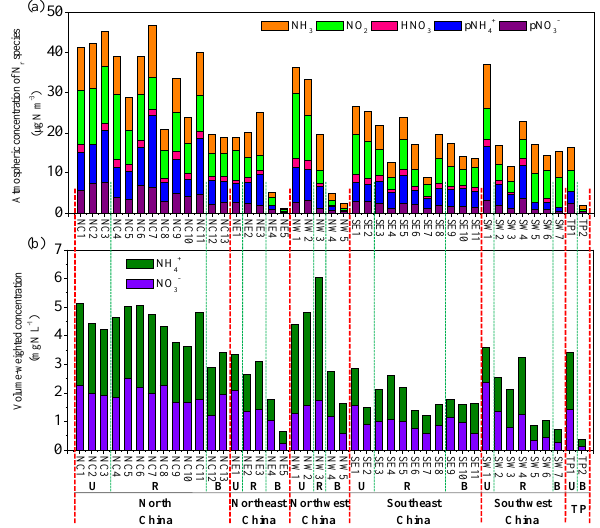
Figure 2. Annual mean concentrations of N r compounds in air (a) and volume-weighted concentrations of inorganic nitrogen species in precipitation (b) at all monitoring sites. U, R, and B denote urban, rural, and background sites, respectively. TP denotes the Tibetan